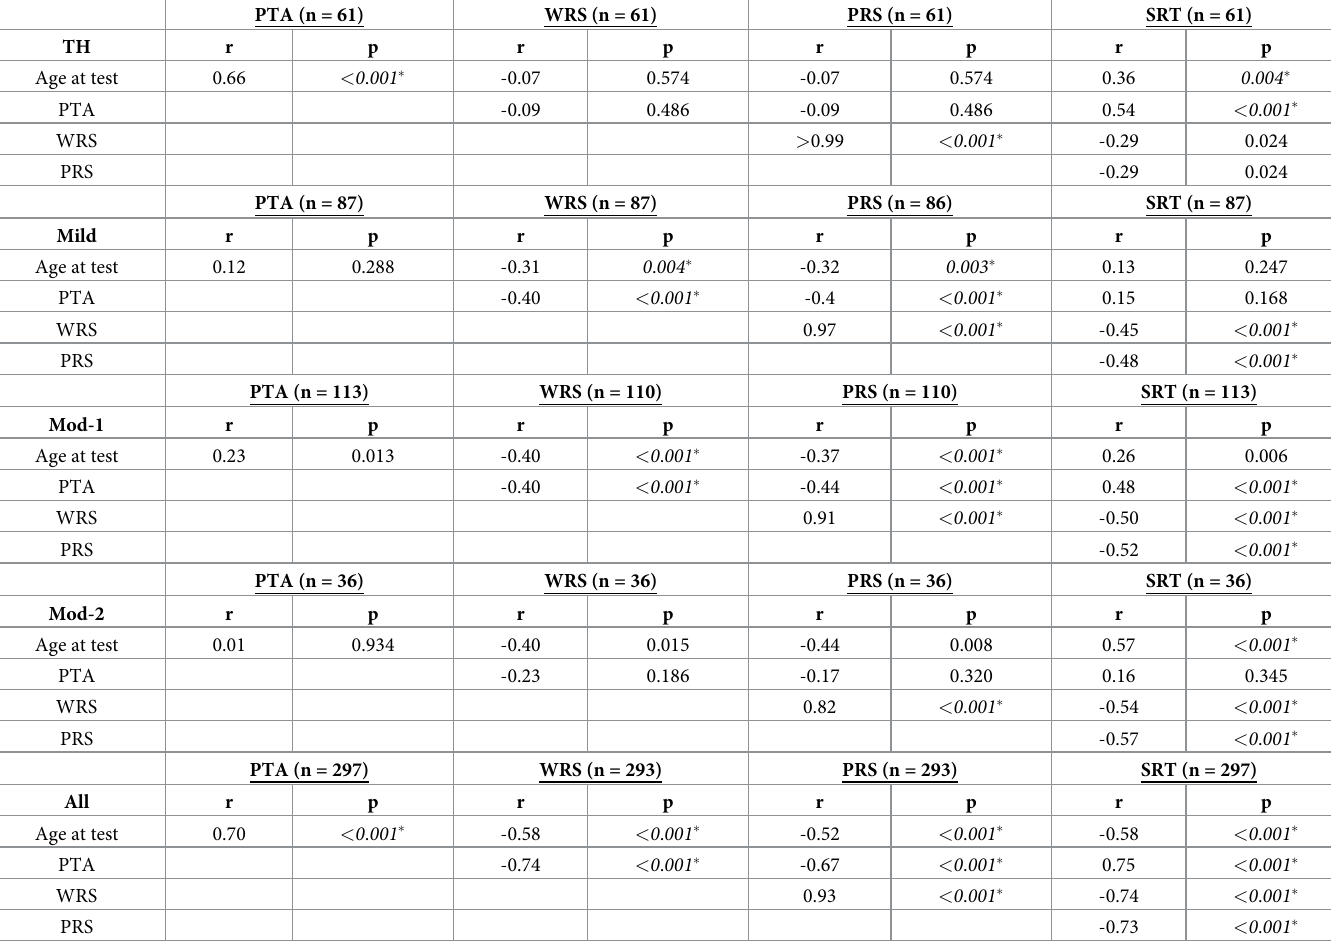
Table 3. Results of Pearson correlations analyses among age at testing, binaural PTA thresholds, word recognition scores (WRS), phoneme recognition scores (PRS), and SRTs. Results are shown within each hearing status group and across all participants. Significant relationships after Bonferroni correction for multiple compar- isons (adjusted p = 0.005) are indicated by asterisks and